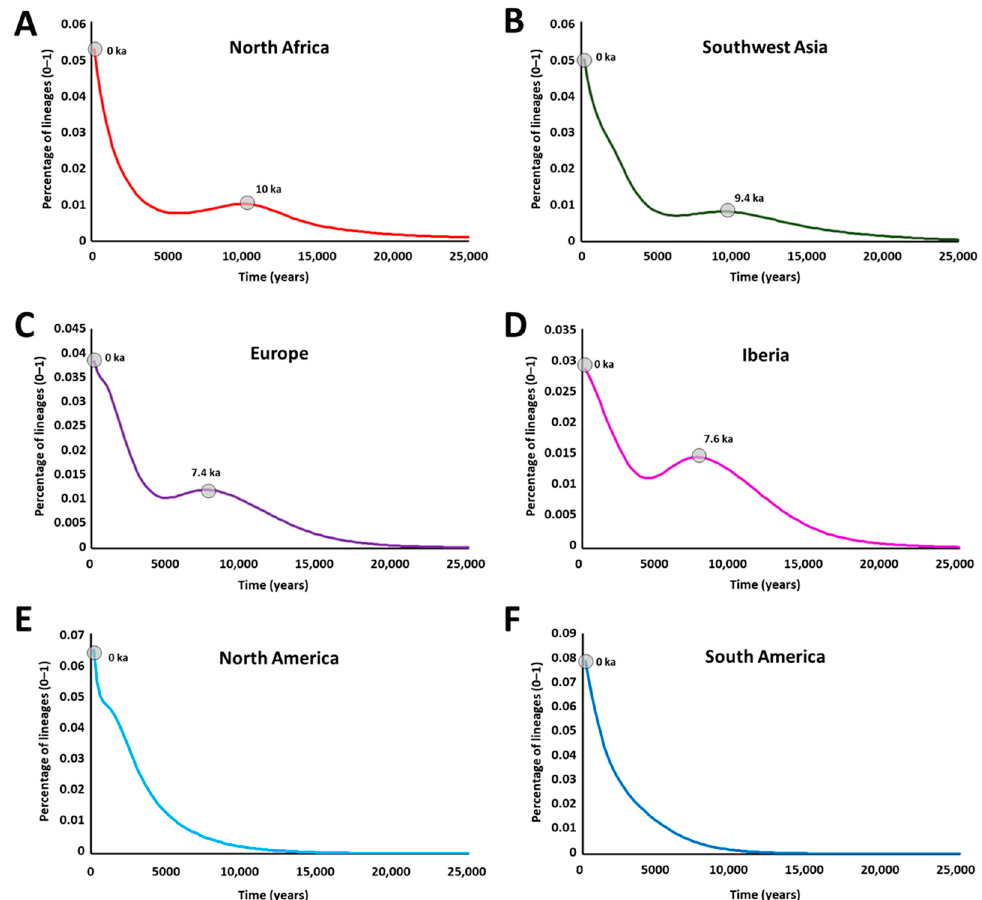
Figure 1. Probabilistic distribution of African mitogenome founder clusters across migration times over time, scanned at 200-year intervals from 0–25ka, for North Africa ( A ), Southwest Asia ( B ), Europe ( C ), Iberia ( D ), North America ( E ) and South America ( F ). Point age estimates for each peak in ka are indicated.